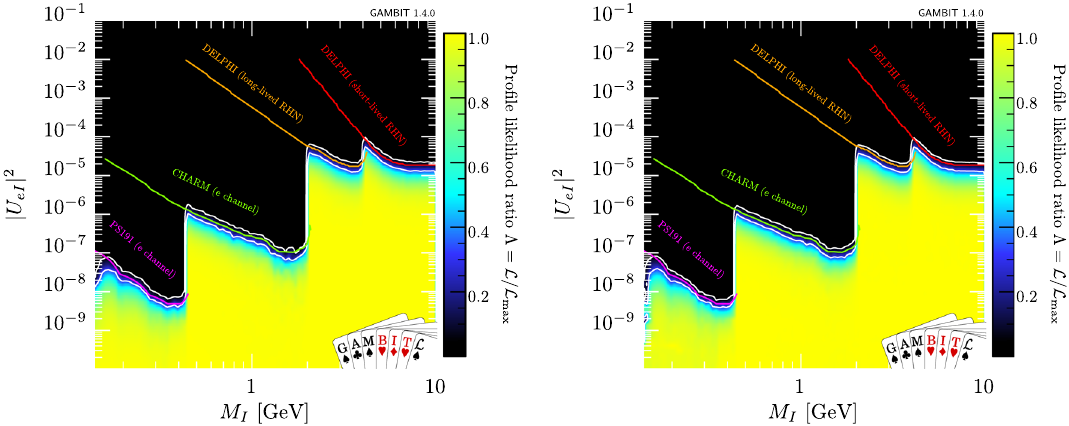
Fig. 8 Profile likelihood in M I vs U 2 plane with M I < 10 GeV and overlaid direct detection limits, for normal (left) and inverted hierarchy (right) eI